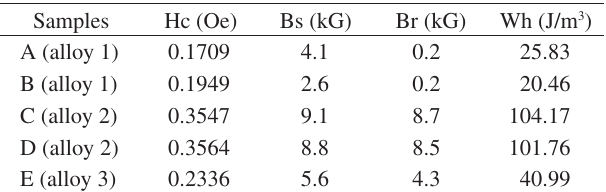
Table 2. Magnetic properties of samples A, B, C, D and E in the as-cast and stress annealed conditions, with f = 10 kHz. Samples